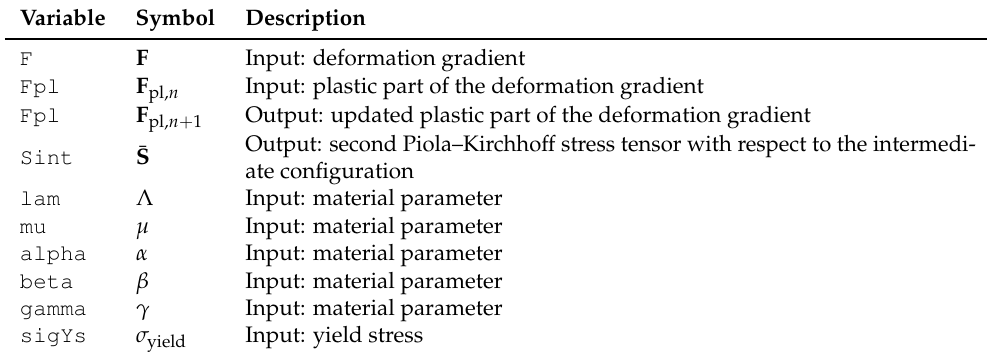
Table 5. List of input and output variables for the subroutine RETMAP in COMSOL Multiphysics ® . Variable